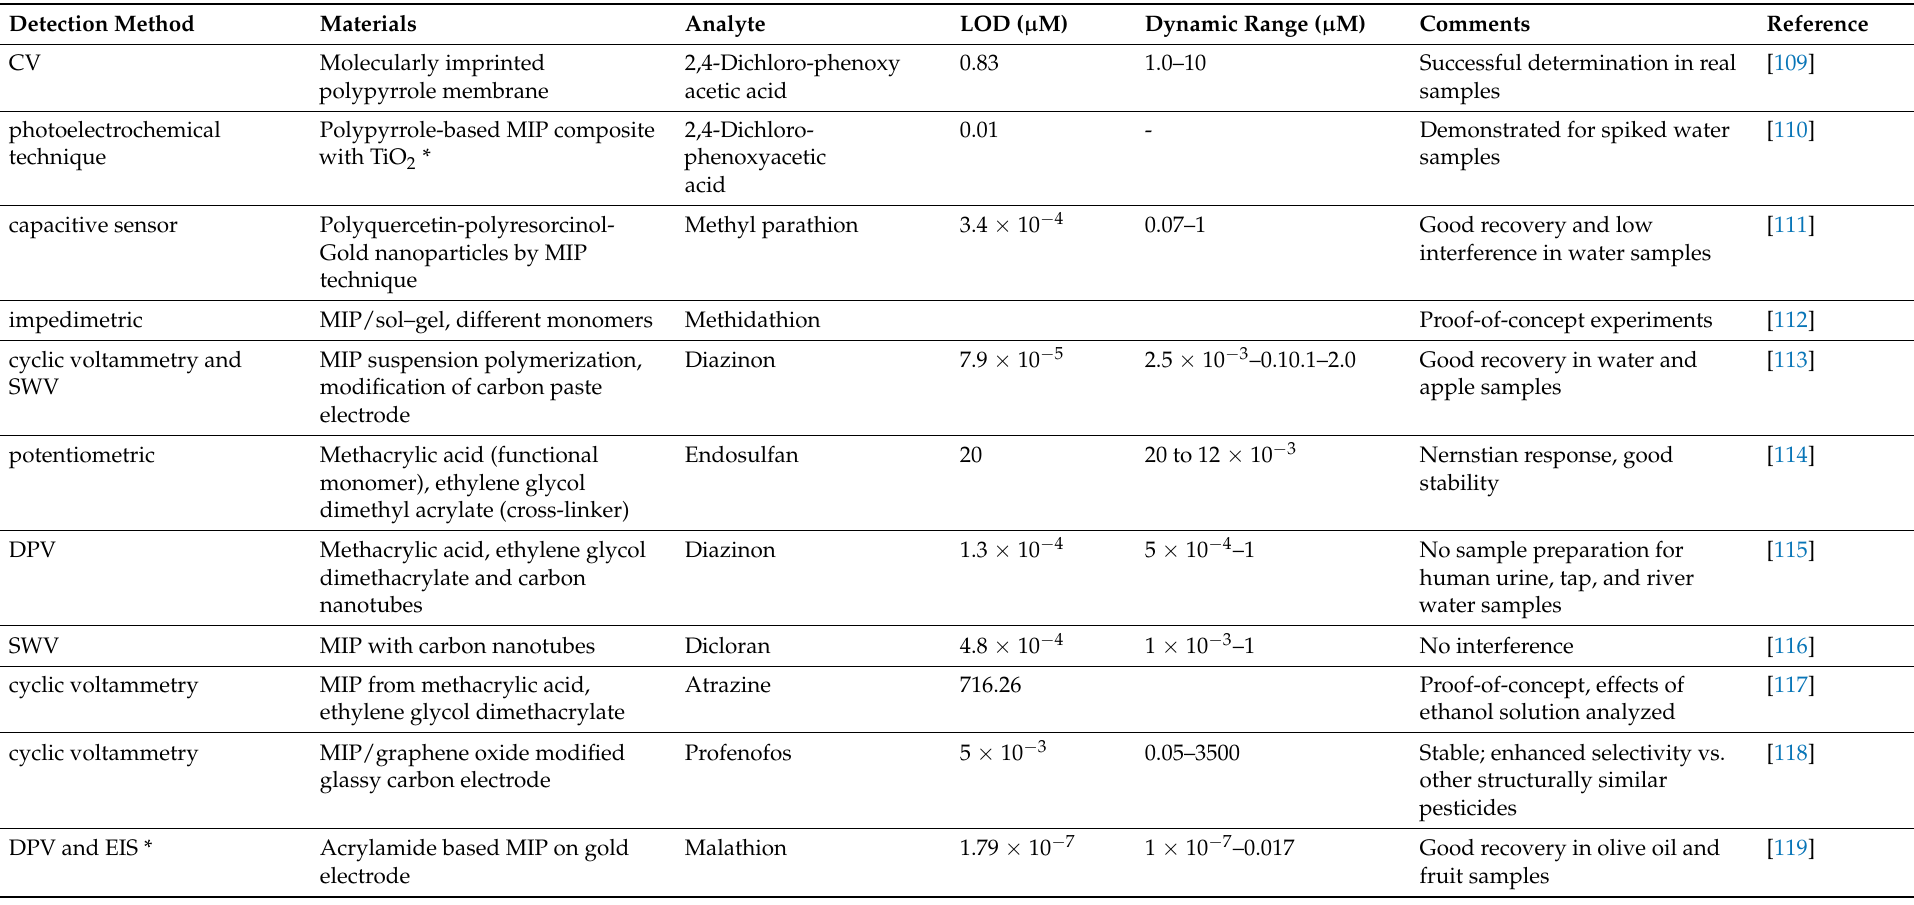
Table 3. Overview of electrochemical sensors for pesticides, based on molecularly imprinted